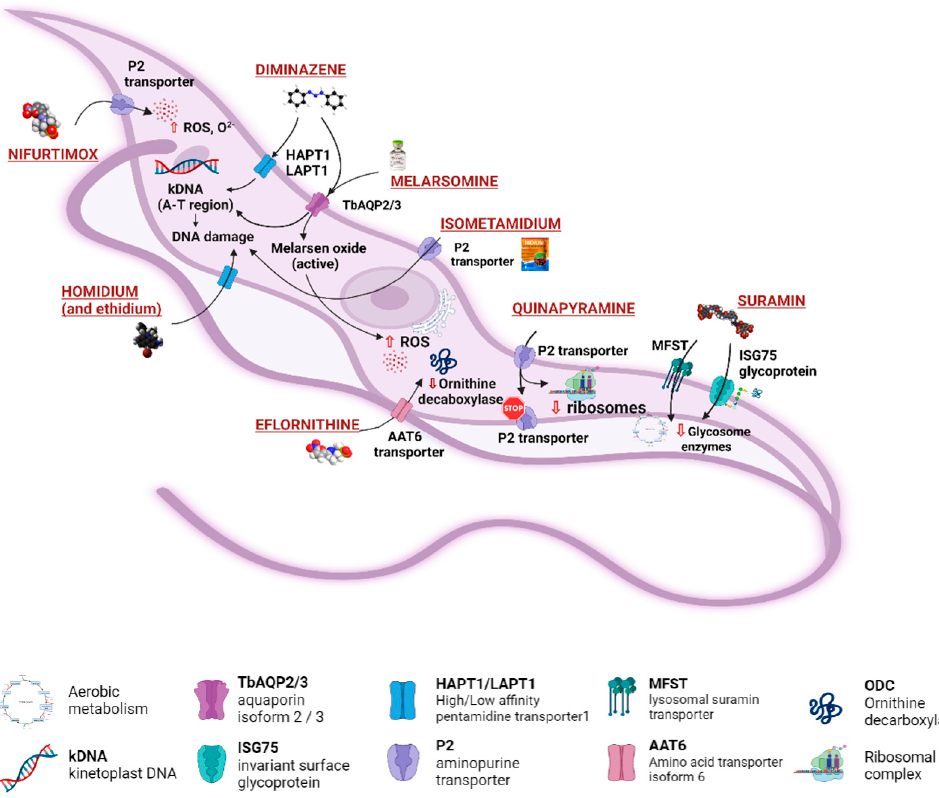
Figure 3. Drugs used to treat AAT and their mechanisms of action are illustrated. The different targets and transporters are reported [41–46,63–65]. Created with Biorender.com, agreement number SY23SM5AX6 13 April 2022.